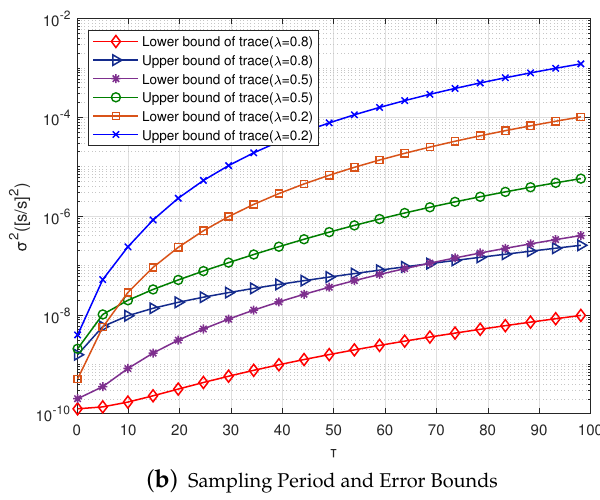
Figure 11. Relationships Between Different Factors and Error Bounds of the Second-order Kalman Filter.